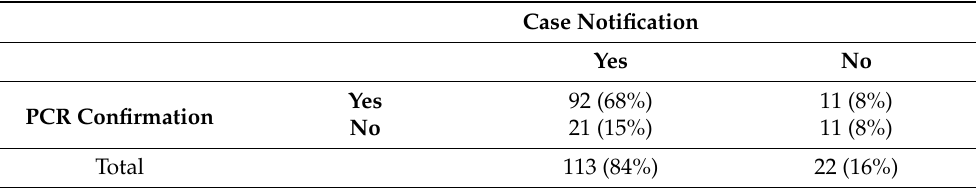
Table 2. Tegumentary leishmaniasis: case notification and/or molecular confirmation at the Regional Reference Laboratory (RRL), Emilia-Romagna region,